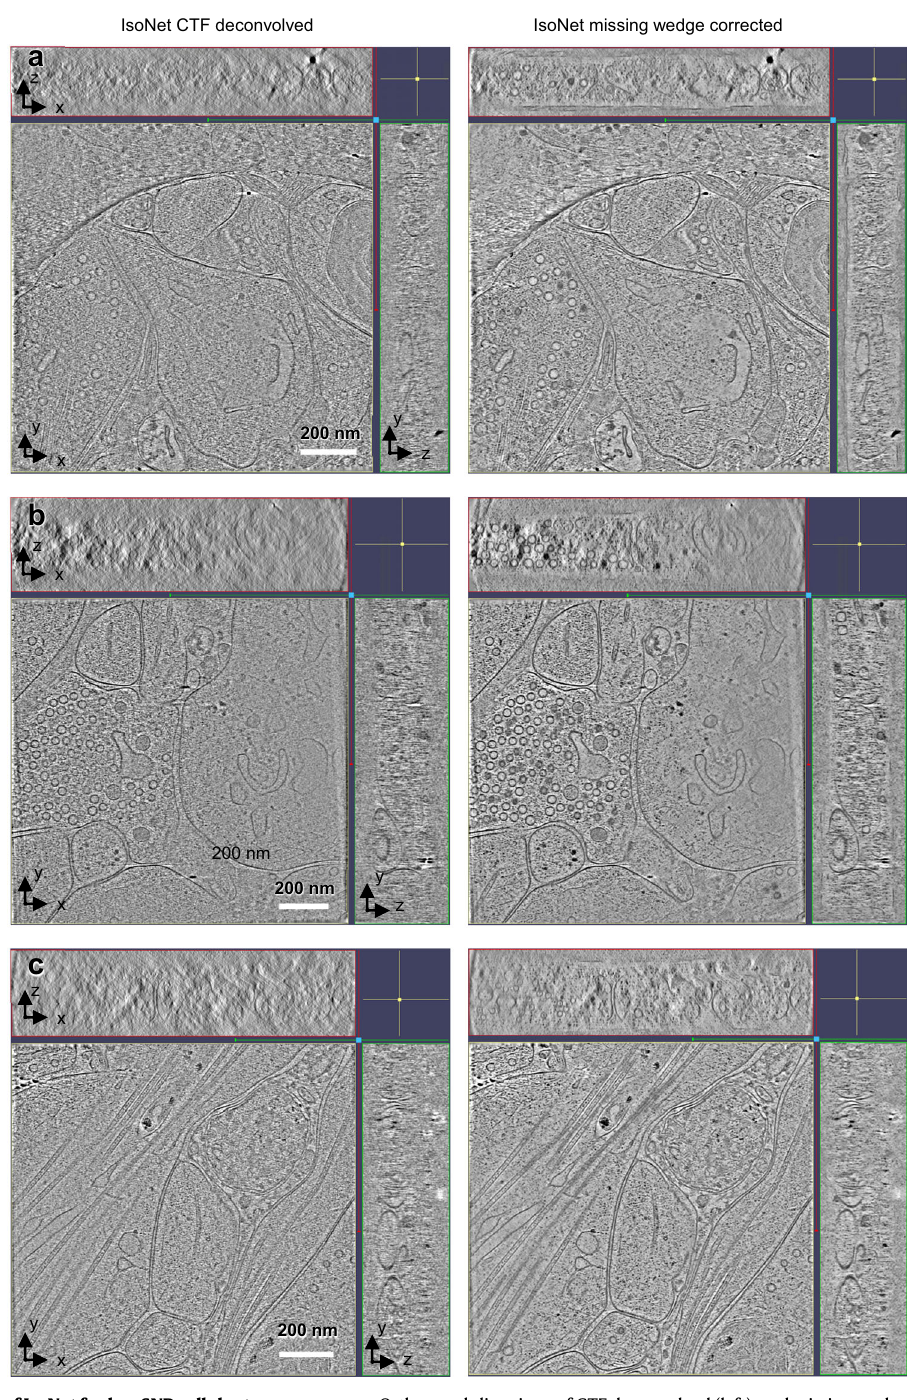
Fig.7|TheperformanceofIsoNetforlowSNRcellulartomograms.a – c OrthogonalsliceviewsofCTFdeconvolved(left),andmissing-wedgecorrected(right)synaptic